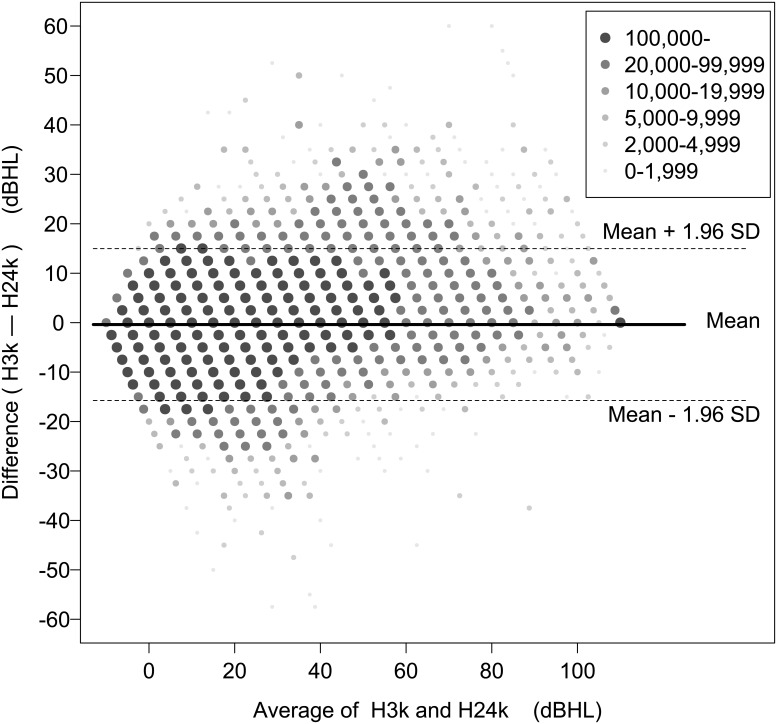
Bland–Altman plot for the threshold at 3 kHz (H3k) and the average of thresholds at 2 kHz and 4 kHz (H24k) (weighted N = 39,357,497 × 2 ears).This plot shows that the absolute limit of agreement is large, which means that H24k cannot be a substitute for H3k. Thick line (center): mean difference (–0.38); dashed lines (top and bottom): upper and lower limits of agreement (15.0 and –15.8, respectively); dBHL: decibel hearing level; SD: standard deviation.